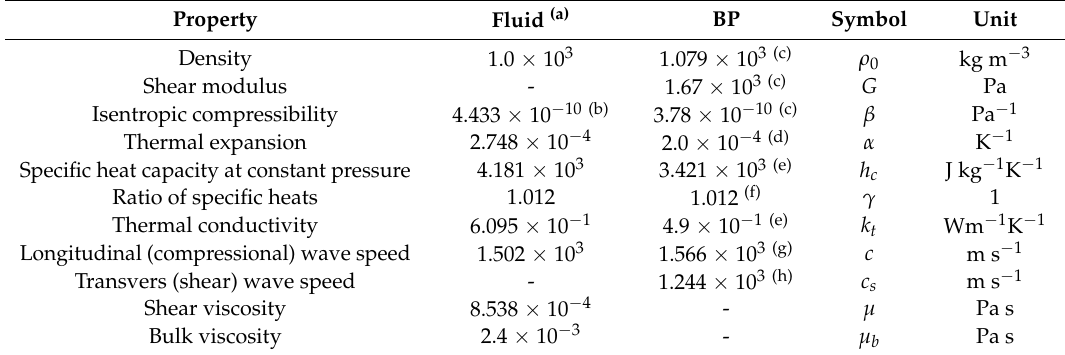
Table 1. Detailed properties of the fluid (water at 25 ◦ C) and BP used in the present study.